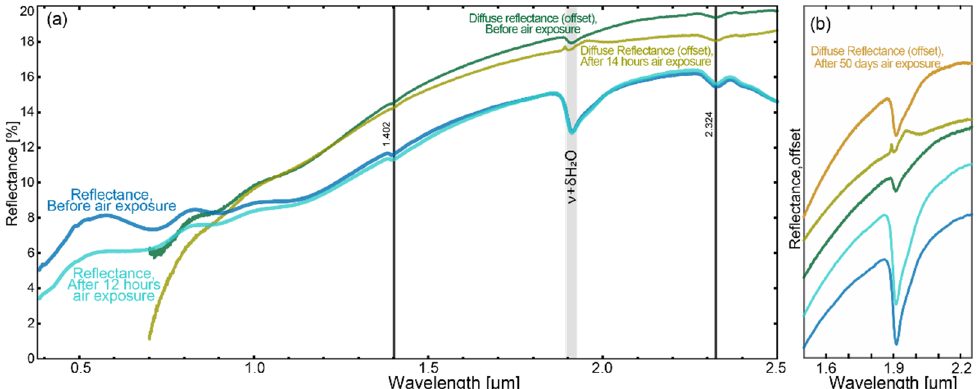
Figure A1. ( a ) Results of VNIR reflectance spectra before and after air exposure for 12 h. The NIR diffuse reflectance spectra are offset and shown for comparison. Note that the continuum components are not removed. Vertical lines show the peak position observed in NIR diffuse reflectance spectra (spectra A1 and B in Figure 4). The solid gray bar shows the position of absorption band due to H ₂ O molecules. ( b ) Close up of a 1.9 μ m wavelength region. The colors of the spectra are the same as those in panel ( a ).